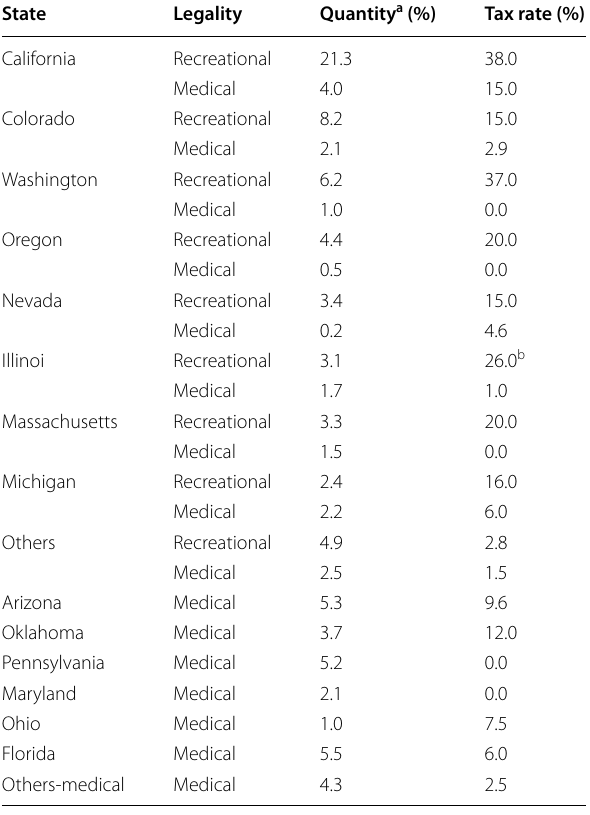
Table 1 2020 medical and recreational cannabis retail market quantity and tax rate of each